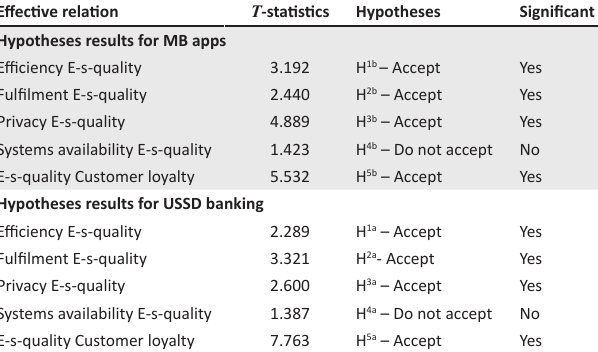
TABLE 6: Hypotheses Summary from partial least squares structural equation modelling path modelling